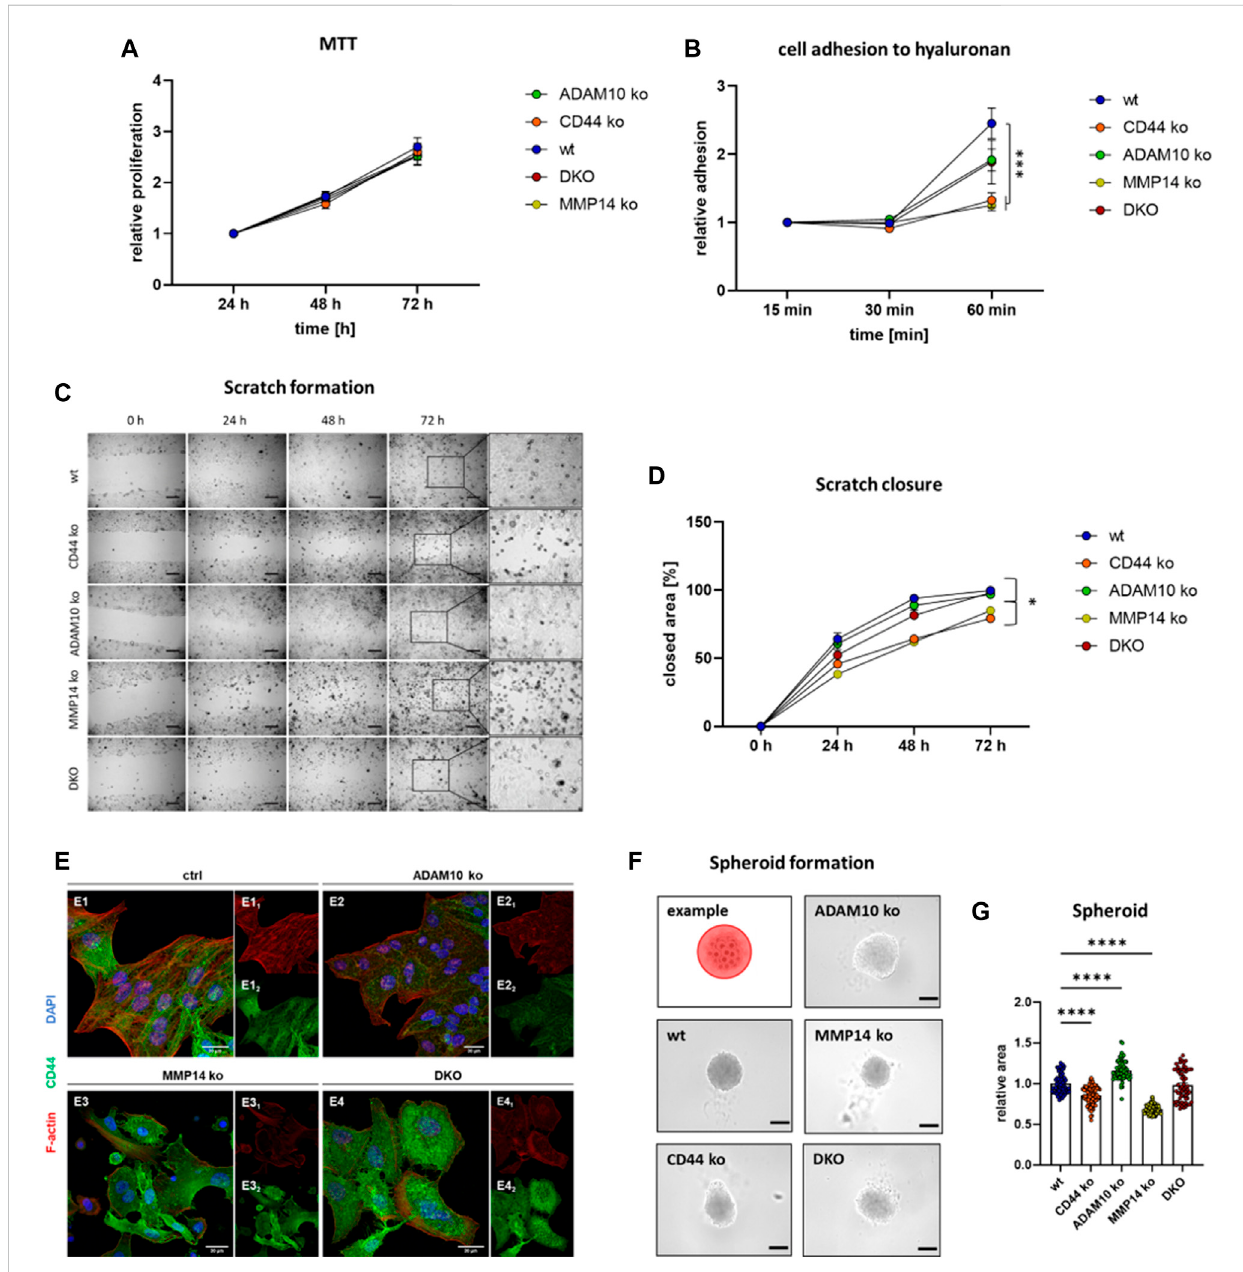
FIGURE 4 Functional consequences for loss of CD44 or its shedding enzymes. (A) Cell viability/proliferation determined with an MTT assay reveals no difference between the different cell lines (n = 15 for wt, CD44 ko, ADAM10 ko and MMP14 ko, n = 8 for DKO, values shown with SEM, two-way ANOVA). (B) Cell adhesion to hyaluronan as determined utilizing a plate and wash assay (n = 9, values shown with SEM, two-way ANOVA, complete statistical analysis in Supplementary Table S1). (C) Closure of a previously applied scratch was determined at 24, 48, and 72 h. Inserts (at right) show magni fi cation of the previous scratch area at 72 h (D) Quanti fi cation of the scratch assay shown in (C) (n = 11, values shown with SEM, two-way ANOVA, completestatisticalanalysisinSupplementaryTableS2). (E) Immuno fl uorescencemicroscopyagainstCD44(green)andF-actin(Phalloidine,red)andthe nucleus (blue). (F) Tumor spheroid formation assay with an exemplary cartoon showing how the spheroid area was determined (upper left corner). (G) Quanti fi cation of individual tumor spheroid areas (n = 62 – 77, individual values shown as mean with SEM, one-way ANOVA, **** p <